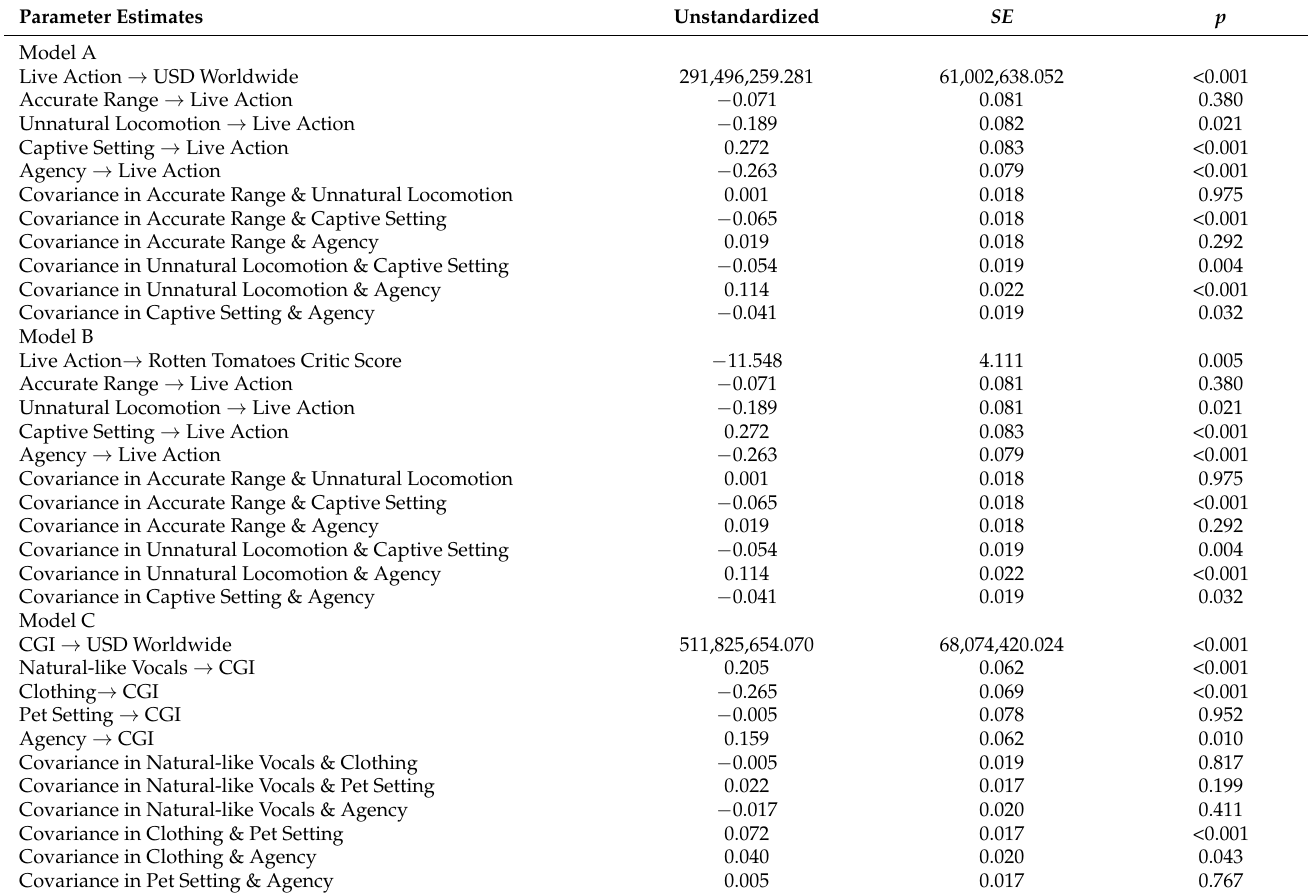
Table A2. SEM Outputs for the models of highest probability for live primates and USD worldwide (Model A), live primates and critic scores (Model B), CGI primates and USD worldwide (Model C), CGI primates and critic scores (Model D), animated primates and USD worldwide (Model E), and animated primate and critic scores (Model